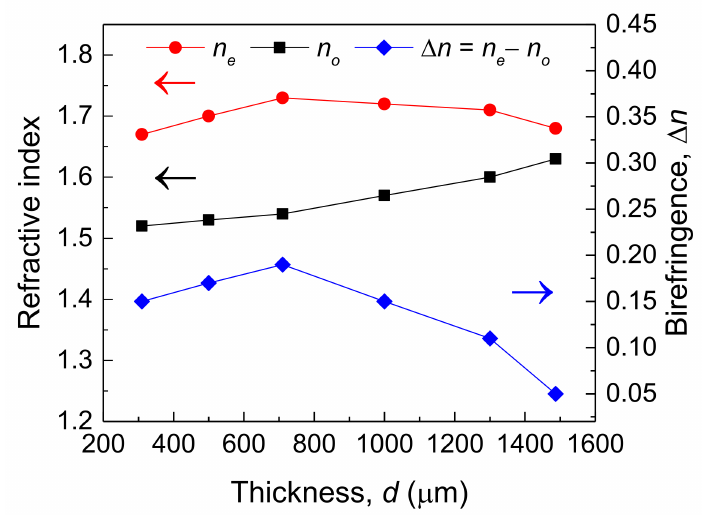
Figure 8. Dependences of n e , n o , and ∆ n on d = 310 µ m, 500 µ m, 710 µ m, 1000 µ m, 1300 µ m, and 1487 µ m.